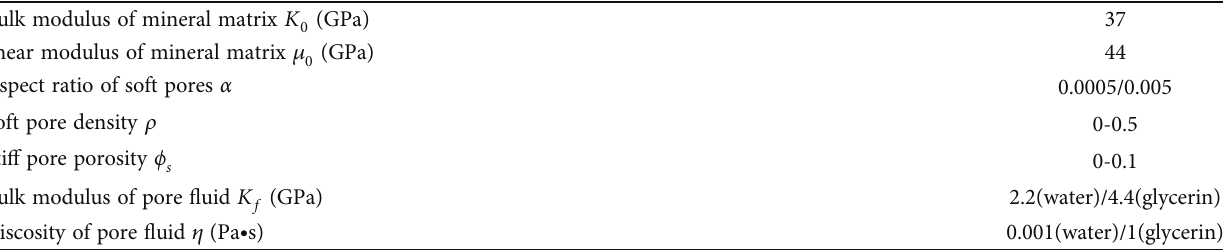
Table 1: The physical parameters in the